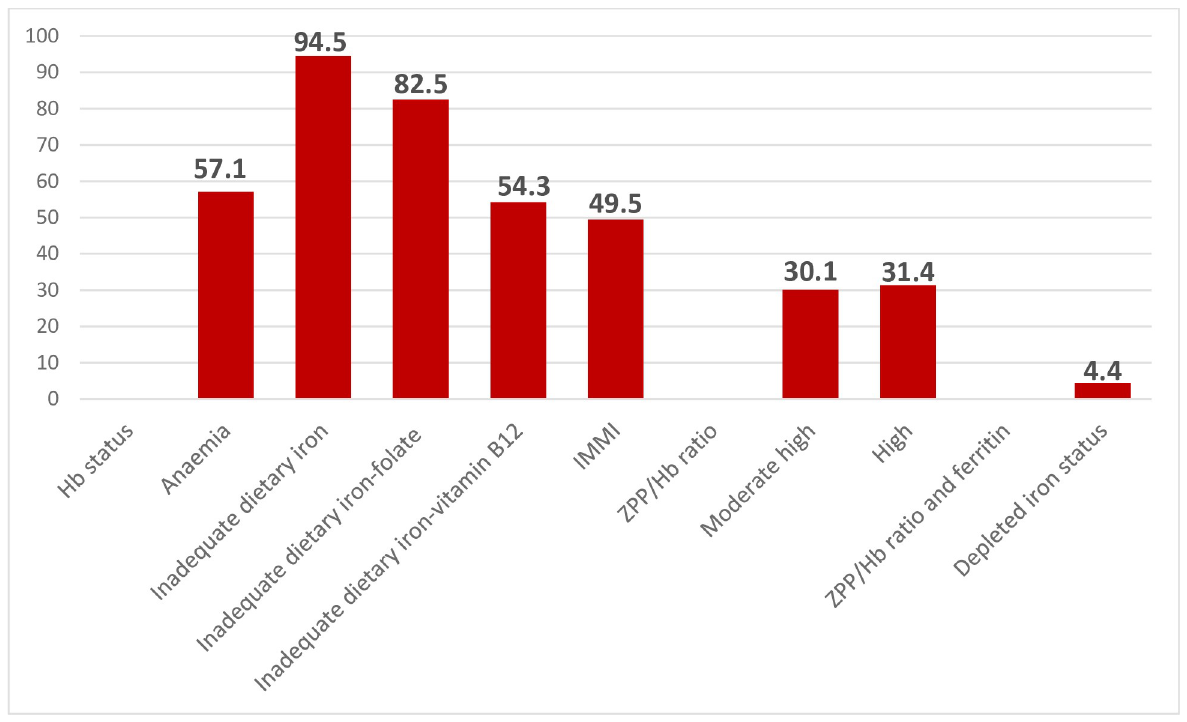
Fig 1. Iron-deficiency anaemia prevalence among pregnant teenagers.